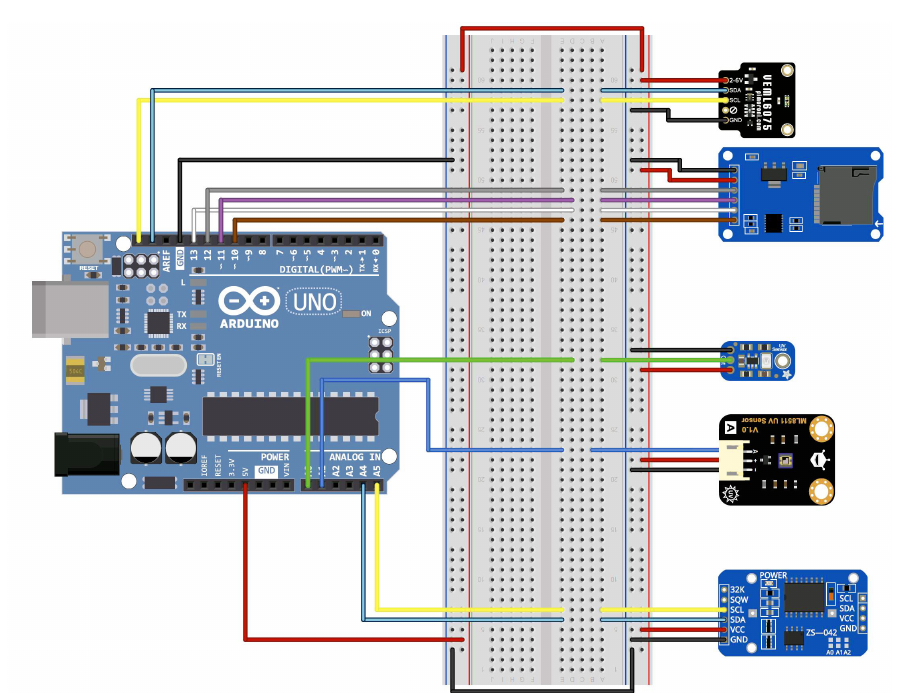
Figure 3. Schematic of the developed testing